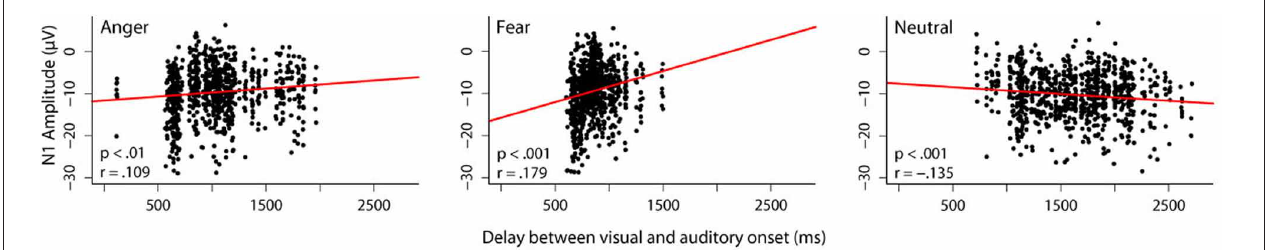
FIGURE 1 | Correlation between audiovisual delay and N1 amplitude. In one of our studies (Jessen et al., 2012), we presented 24 participants with videos, in which different emotions were expressed by body and vocal expressions simultaneously. The delay between the visual and the auditory onset was different for each stimulus. In order to investigate the influence that a different amount of visual information has on the subsequent auditory processing, we correlated the length of the audiovisual delay with the N1 amplitude separately for each emotion. Trials in which the N1 amplitude differed more than 3 standard deviations from the mean were